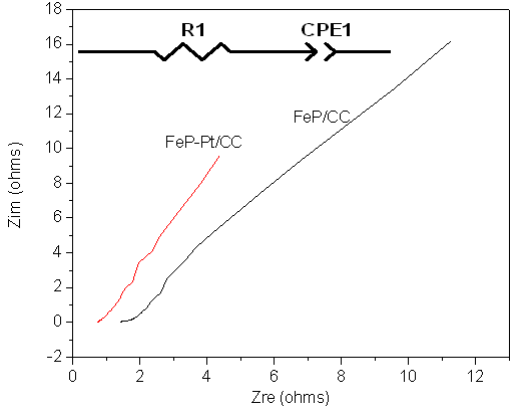
Figure 6. Nyquist plots of FeP-Pt/CC and FeP/CC at − 0.2 V in 0.5 M H 2 SO 4 with inset the equivalent electrical circuit. Table 1. Element values in the equivalent circuit of AC impedance spectrum in 0.5 M H 2 SO 4 . Element